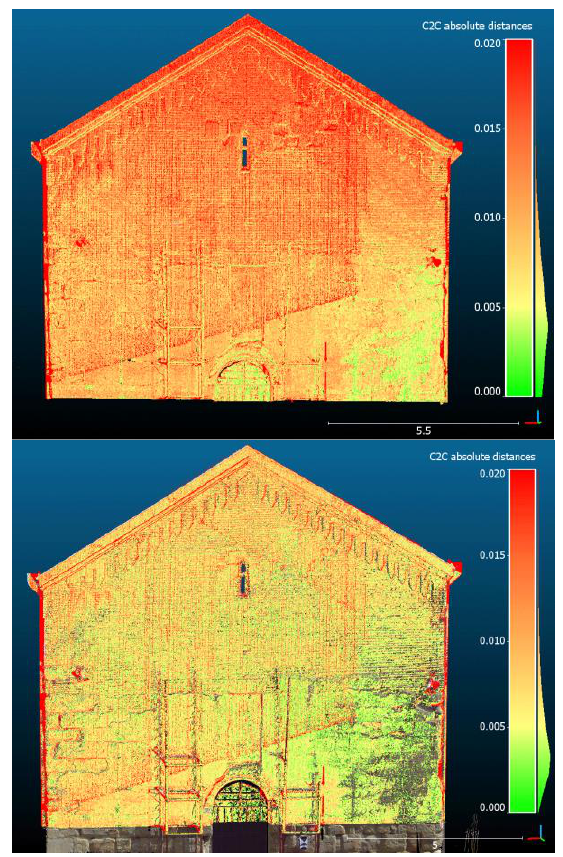
Figure 6. Comparison Faro-BLK: left Cloud-to-Cloud; right Cloud-to-Cloud after ICP (in mm)